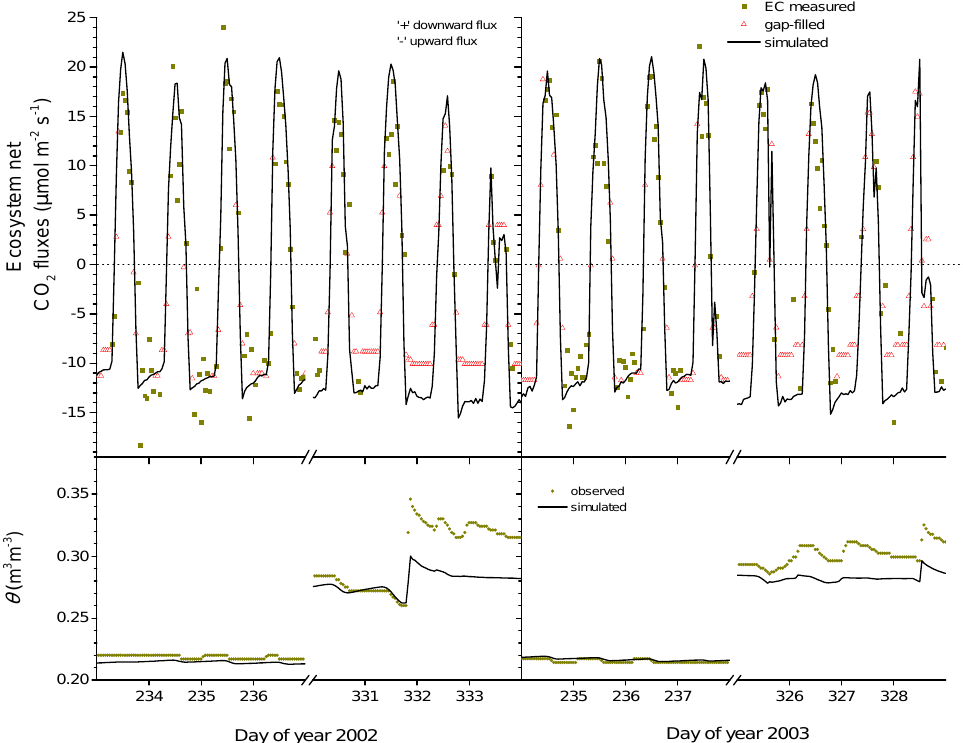
Fig. 1. Hourly EC measured, gap-filled and simulated net ecosystem CO 2 fluxes and observed and simulated soil water contents ( θ) from 0–0.20m depth of the hummock during 2002 and 2003 over a drainage affected tropical peat swamp forest at Palangkaraya,